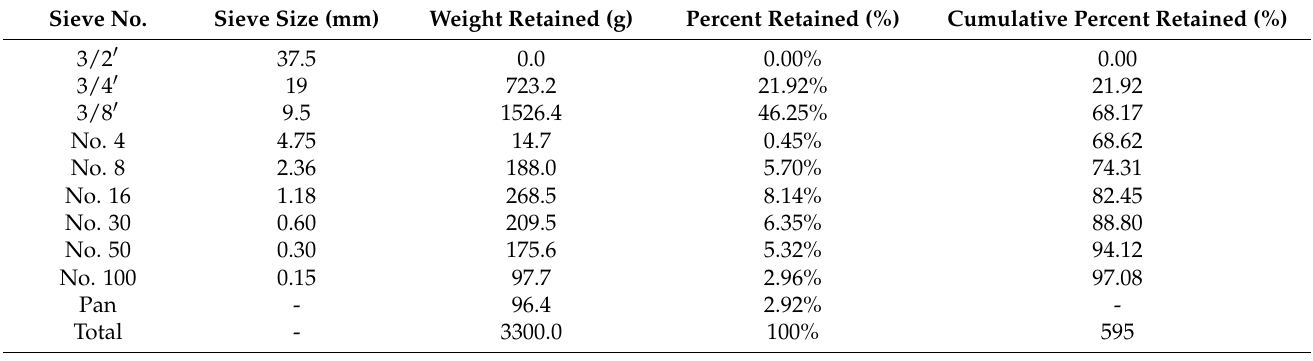
Table 2. Fineness modulus of